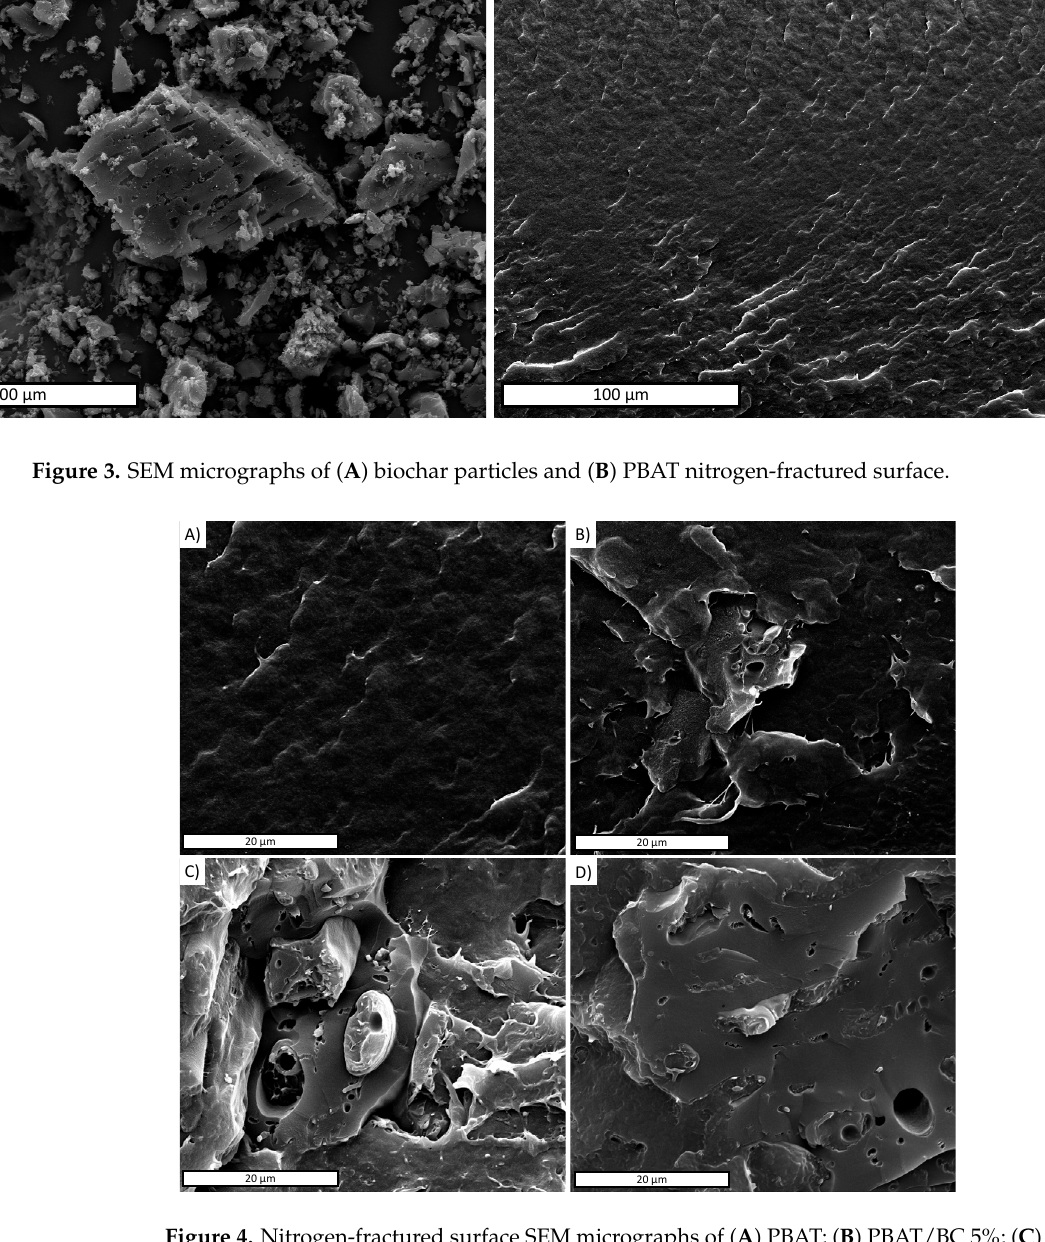
Figure 4. Nitrogen-fractured surface SEM micrographs of ( A ) PBAT; ( B ) PBAT/BC 5%; ( C ) PBAT/BC 10%; ( D ) PBAT/BC 20%.